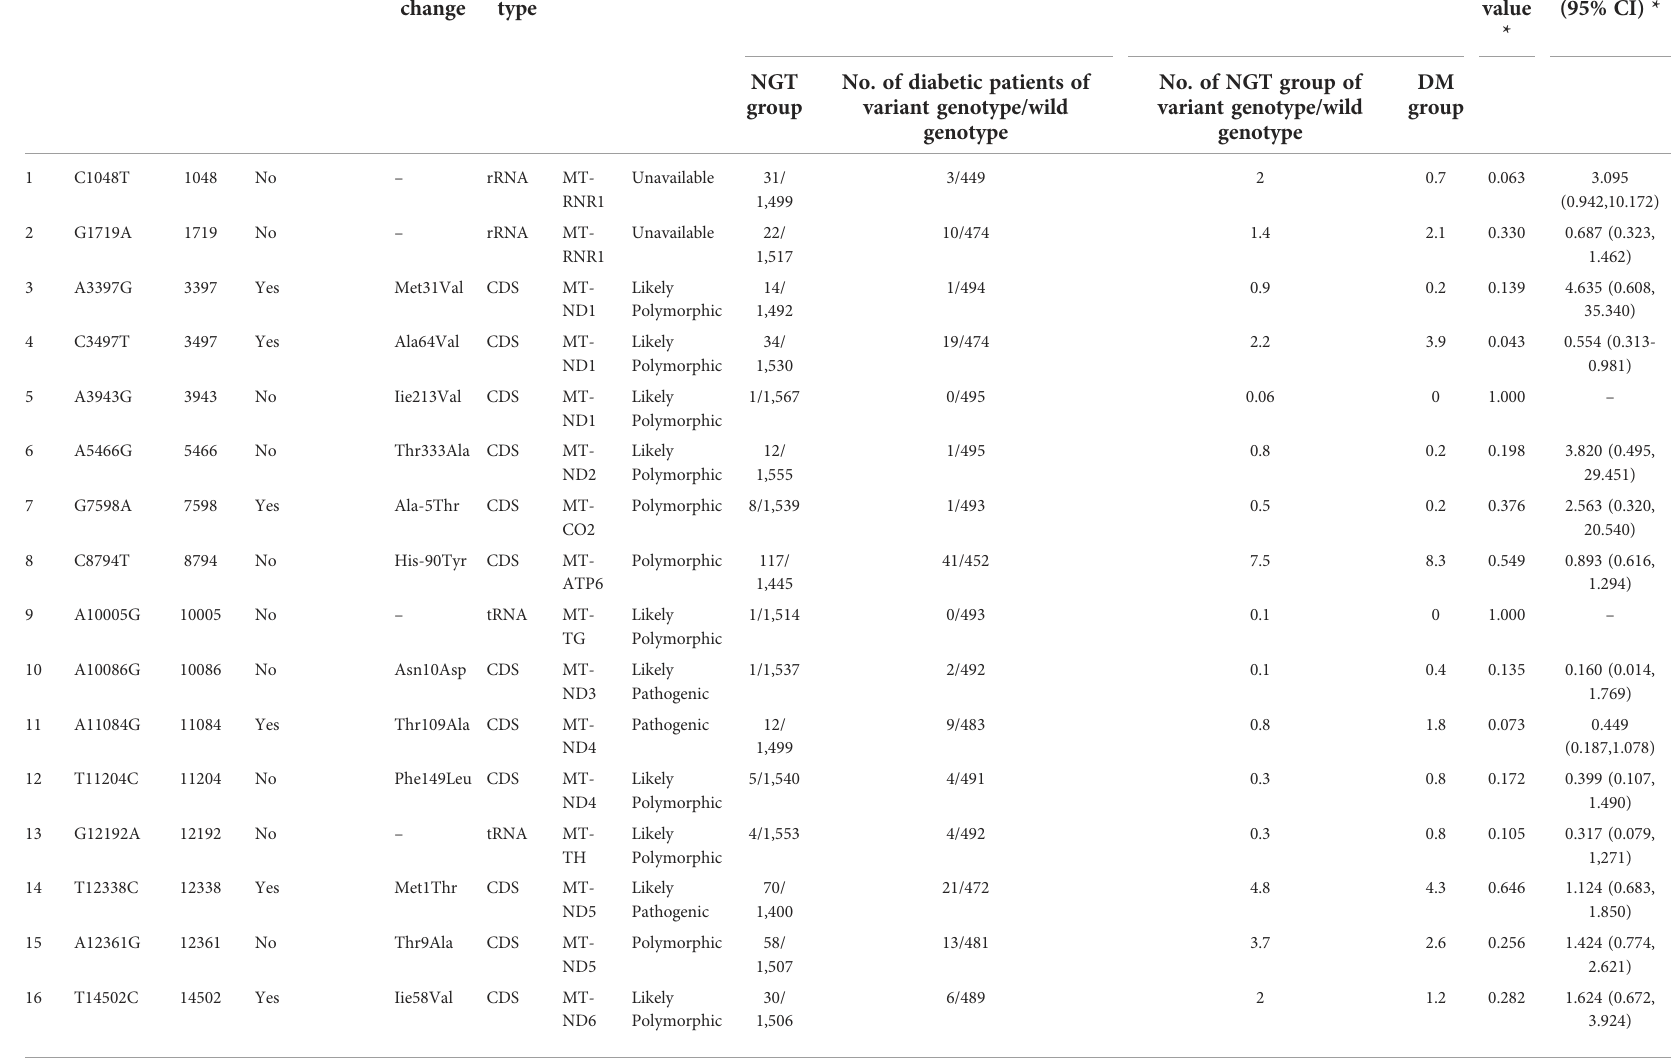
TABLE 7 The analysis of 20 mtDNA variants in the case – control study from cohort